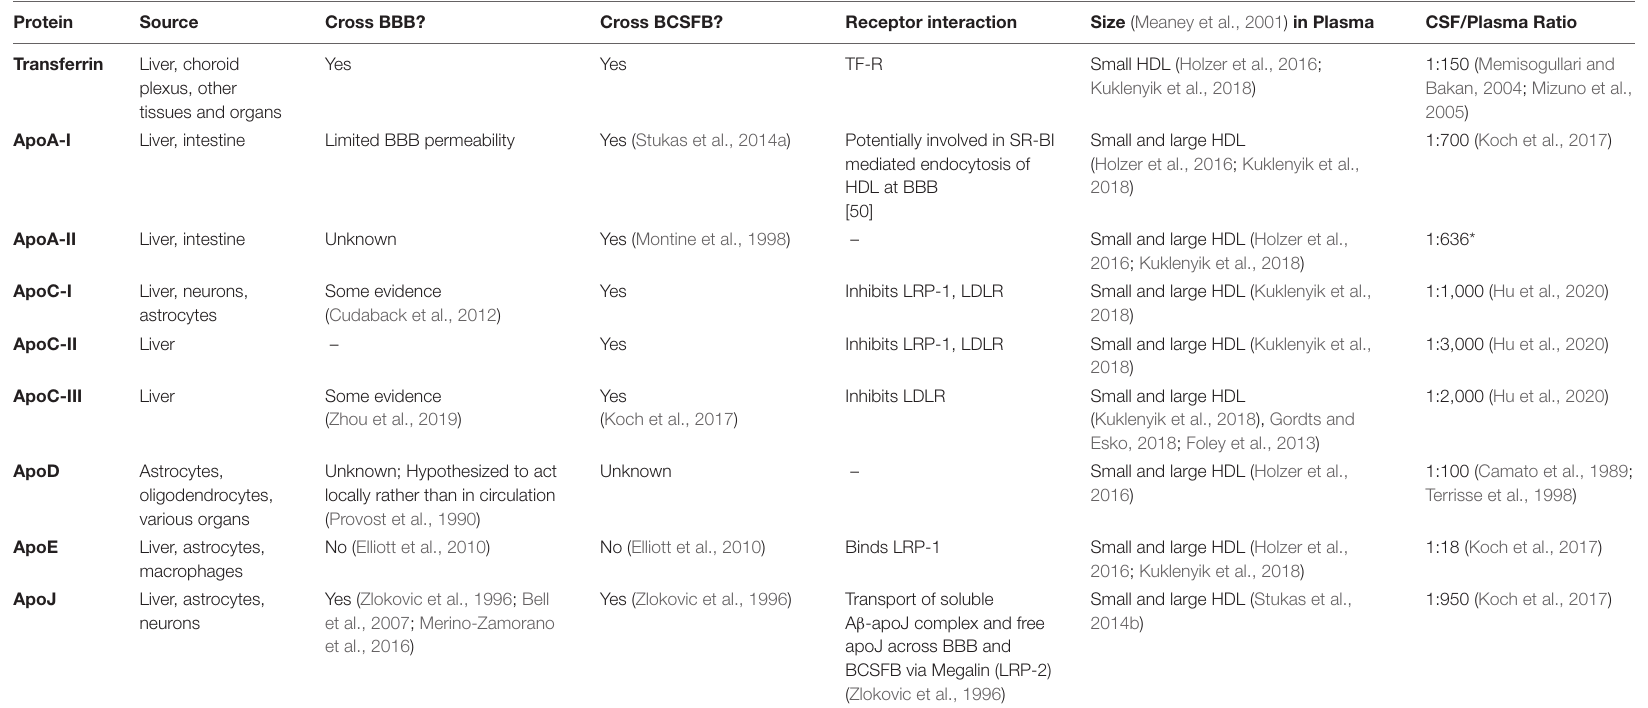
TABLE 1 | Summary of HDL-associated proteins’ source, function, and association. Protein Source Cross BBB? Cross BCSFB? Receptor